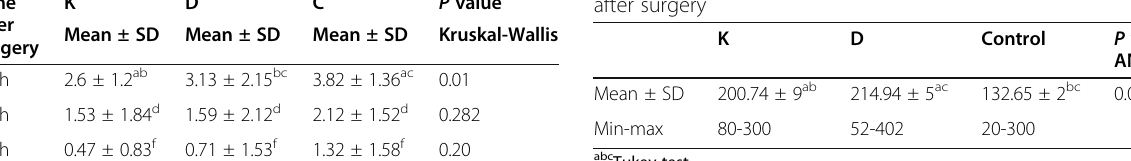
Table 2 Mean number of analgesic intake by patients 24, 48, and 72 h after surgery Time K after surgery